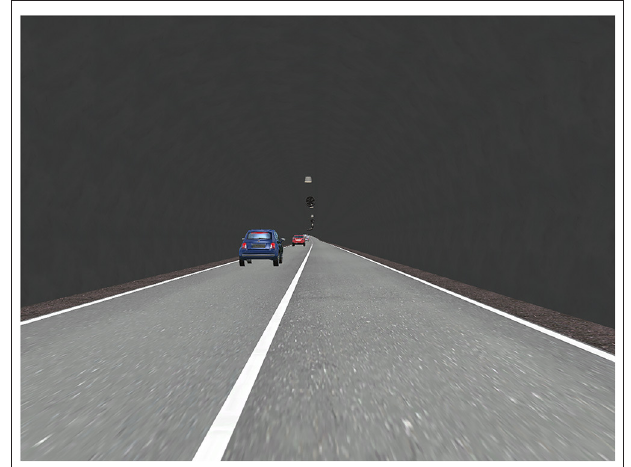
FIGURE 1 | Experimental scenarios of the study highway